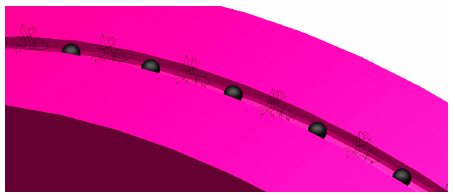
Figure 4. Model of the contact section between the rope and pulley.